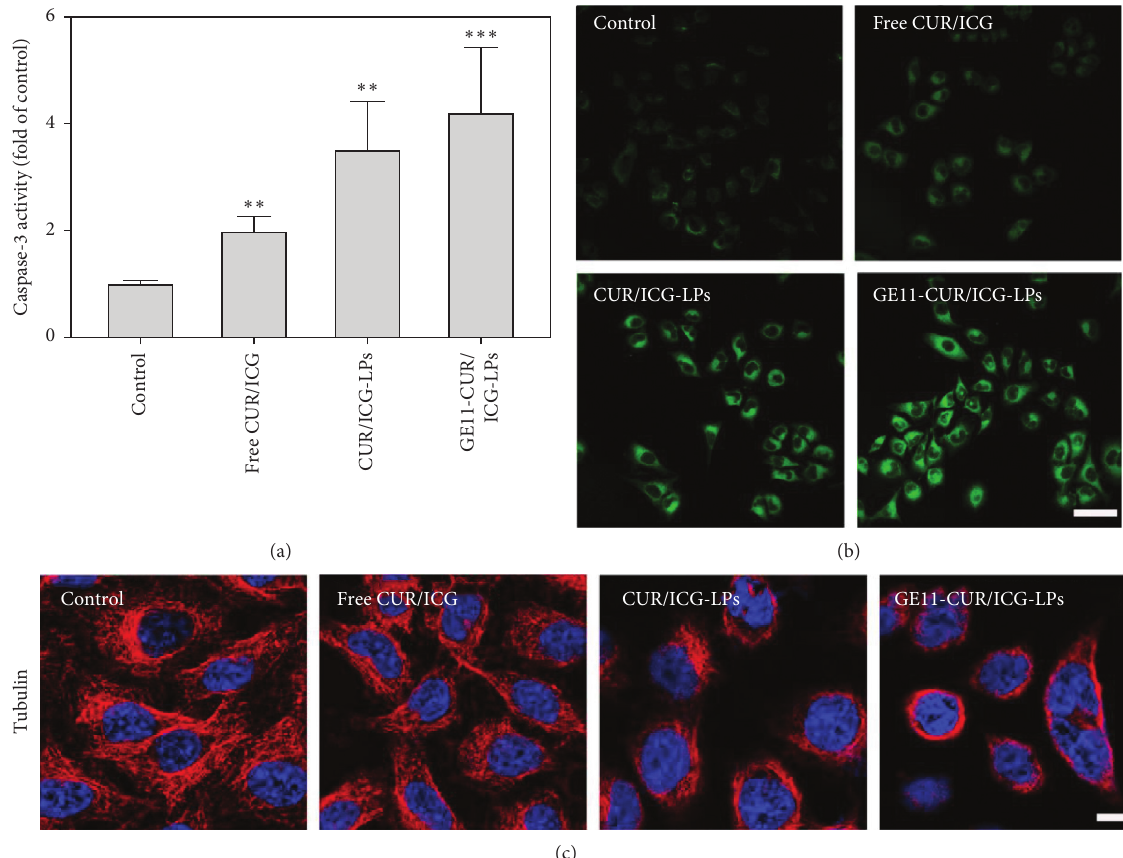
Figure 6: (a) Effects of IC-GLPs on the caspase-3 activity in A549 cells, data are expressed as mean ± SD ( n � 3). ∗ P < 0 . 05, ∗∗ P < 0 . 01 and ∗∗∗ P < 0 . 001. (b) Intracellular ROS detection by the DCFH-DA fluorescence staining. Scale bar � 50 μ m. (c) Cytoskeletal microtubulin (red) expression in A549 cells after different treatments with laser irradiation. DAPI (blue) counterstains cell nuclei. Scale bar � 10 μ